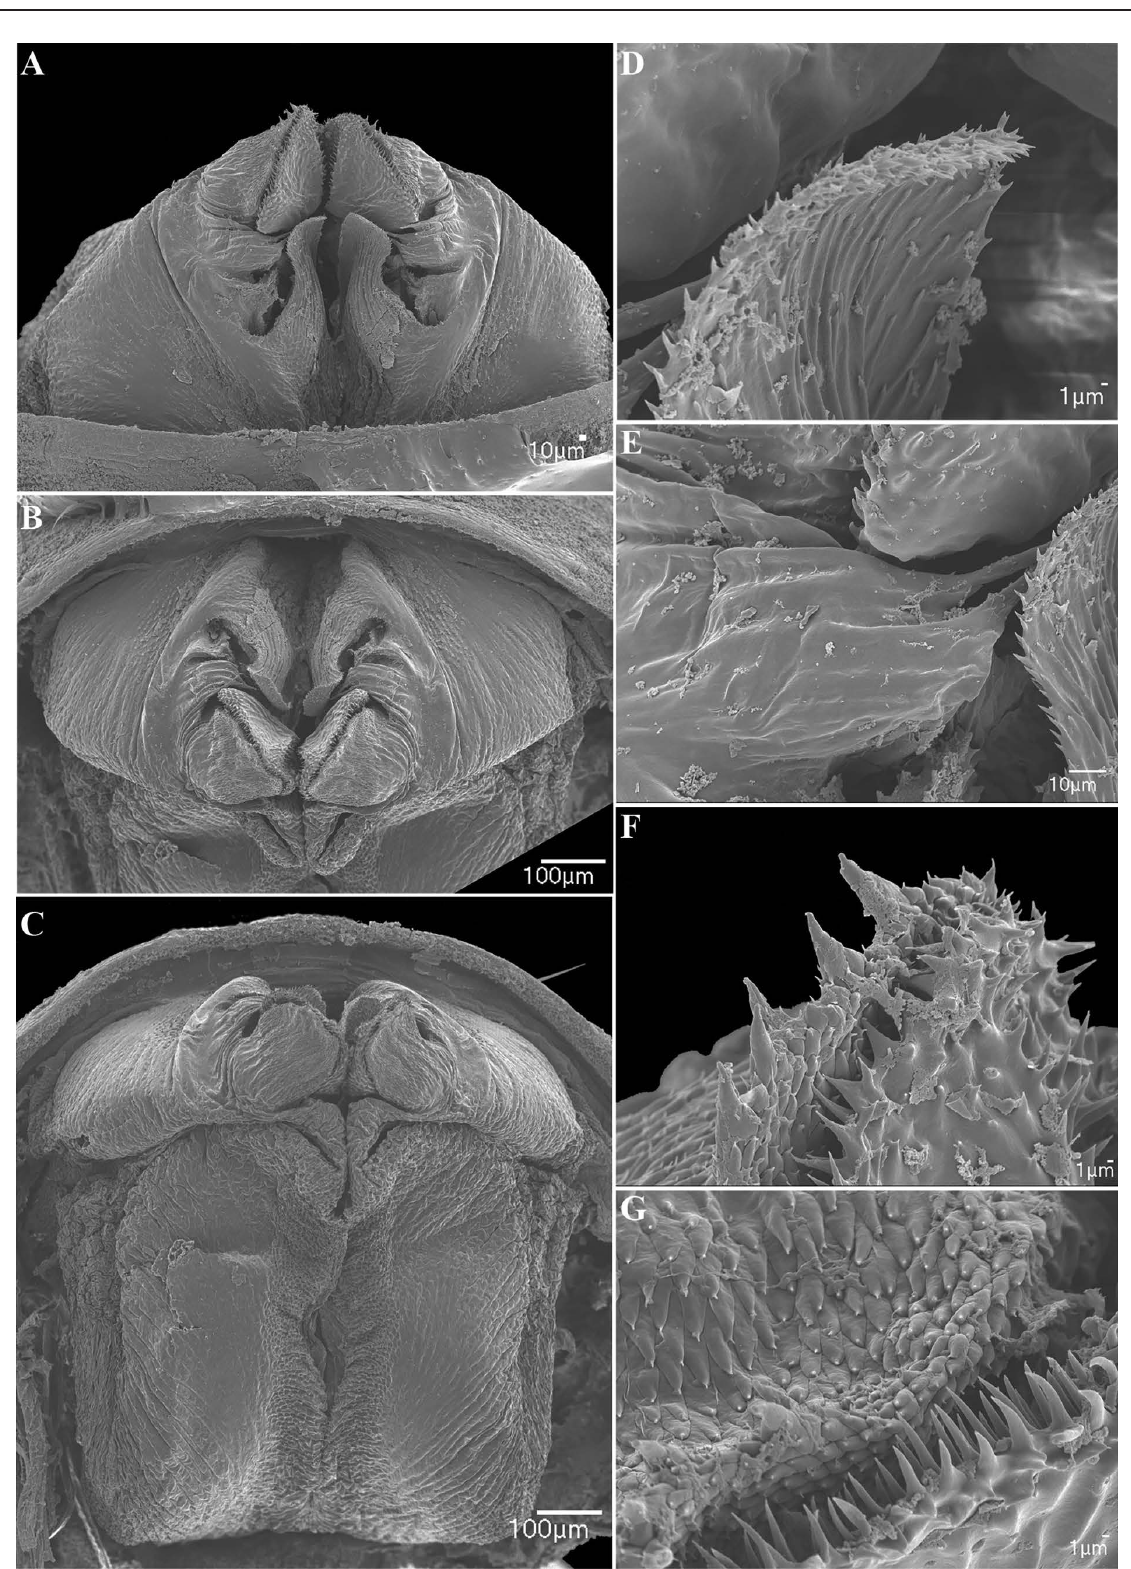
Fig. 85. Charinus africanus Hansen, 1921 (AMCC [LP 6943]), male gonopod. A . Ventral view. B . Posterior view. C . Dorsal view. D . Lamina medialis. E . Lateral lobe 2. F . Junction between dorsal lobe and lateral lobe 1. G . As F,